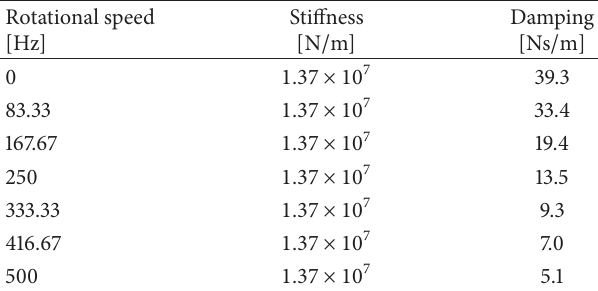
Table 1: Stiffness and damping dynamics coefficients of the front bearing as a function of the rotational